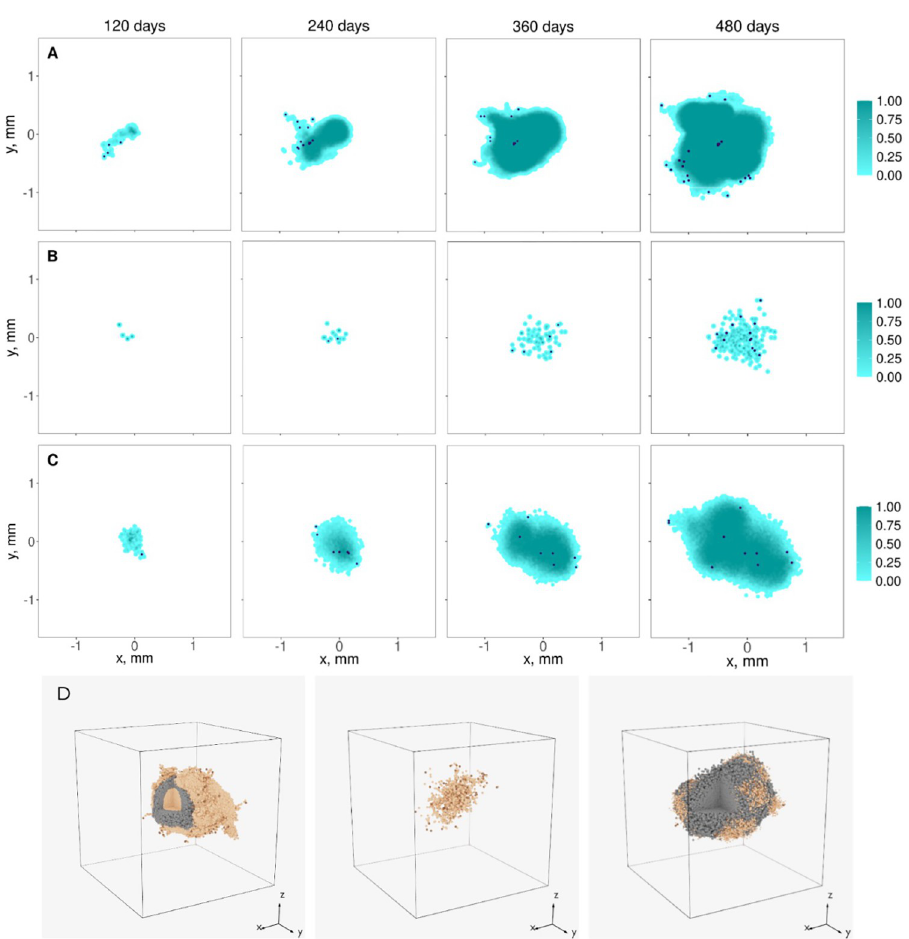
Fig 3. Scaled spatio-temporal evolution of the tumor. The relation between CSC and PC migration and proliferation rates, R , the asymmetric division probability, k , and the maximum number of progenitor cell divisions, d , define the max evolution in time of the tumor shape and size. In panels A-C, the turquoise scale bar represents the normalized cancer cell density of slices at the center of the tumors with 0.2 mm thickness every 4 months; the dark blue dots are CSCs. In panel D, dark brown, light brown, and grey dots represent CSCs, PCs, and senescent cells, respectively. Thus, three scenarios are presented: R < 1, high probability of asymmetric division, k = 0.95, and a large maximum number of progenitor cell divisions, d = 18 (panel A); R ~ 1, low probability of asymmetric division, k = 0.75, and d = 18 max max (panel B); R ~ 1, k = 0.95, and a small maximum number of progenitor cell divisions, d max = 9 (panel C). The spatial QSP algorithm calculated the evolution of three-dimensional tumors for 16 months starting from one CSC located at the center of the grid. Panel D shows the three-dimensional spatial representation of the tumors from panels A-C after 16 months of growth. All simulations were performed in a 3x3x3 mm grid. Cases with spherical shapes are included in section B.1 of the S1 Supplementary Material. The scaling factor is γ =1 in all